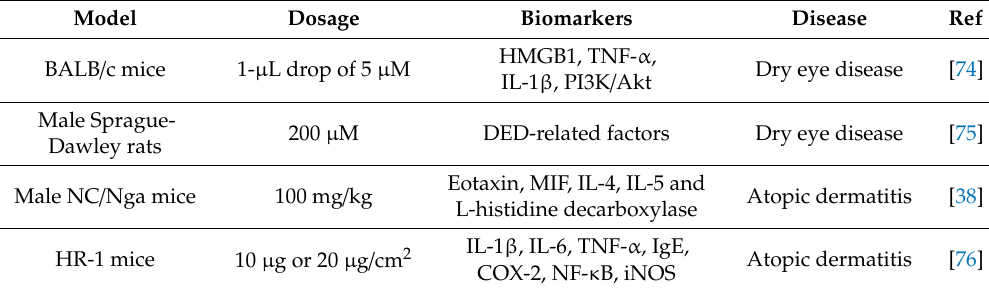
Table 4. The anti-inflammatory e ff ects of astaxanthin in skin and eye